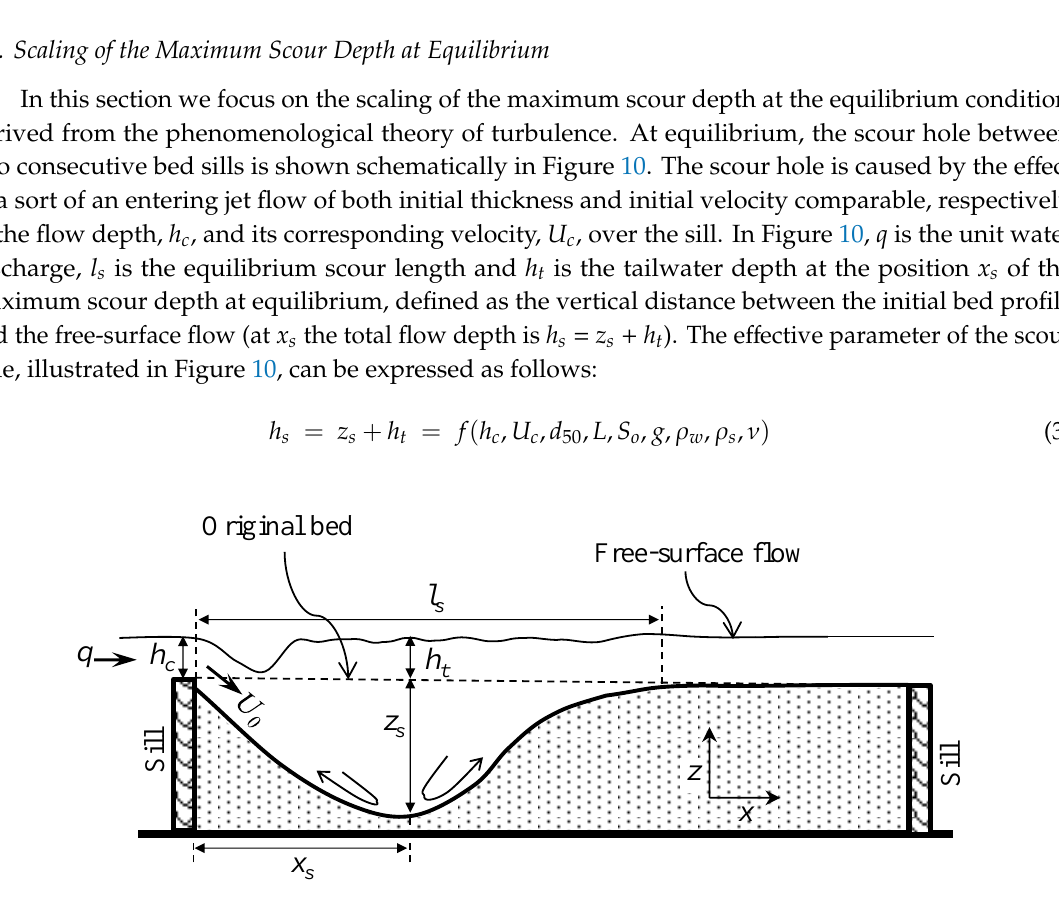
Figure 10. Definitional sketch of scour hole downstream of bed sills, Uo indicates the initial jet velocity.